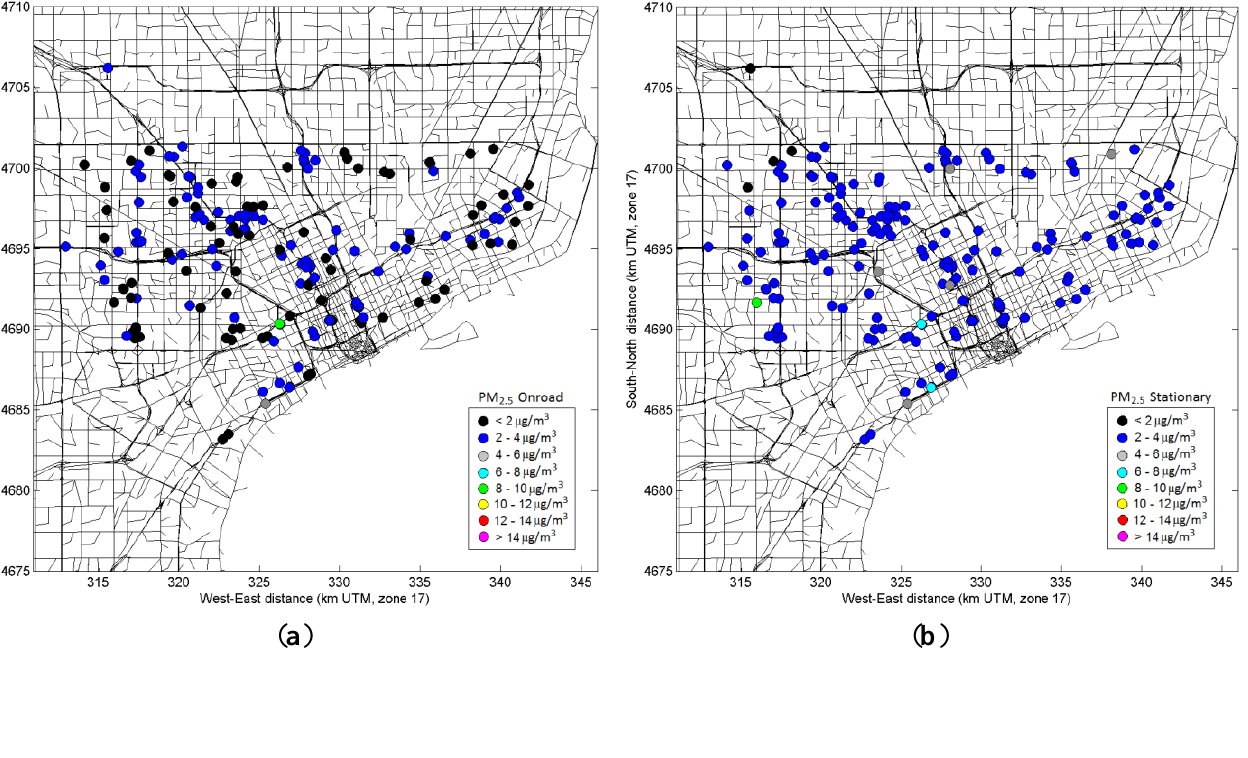
Figure 10. Spatial maps of modeled daily PM September–October 2010, showing contributions from mobile sources ( a ); stationary sources ( b ); urban background ( c ); and total ( d